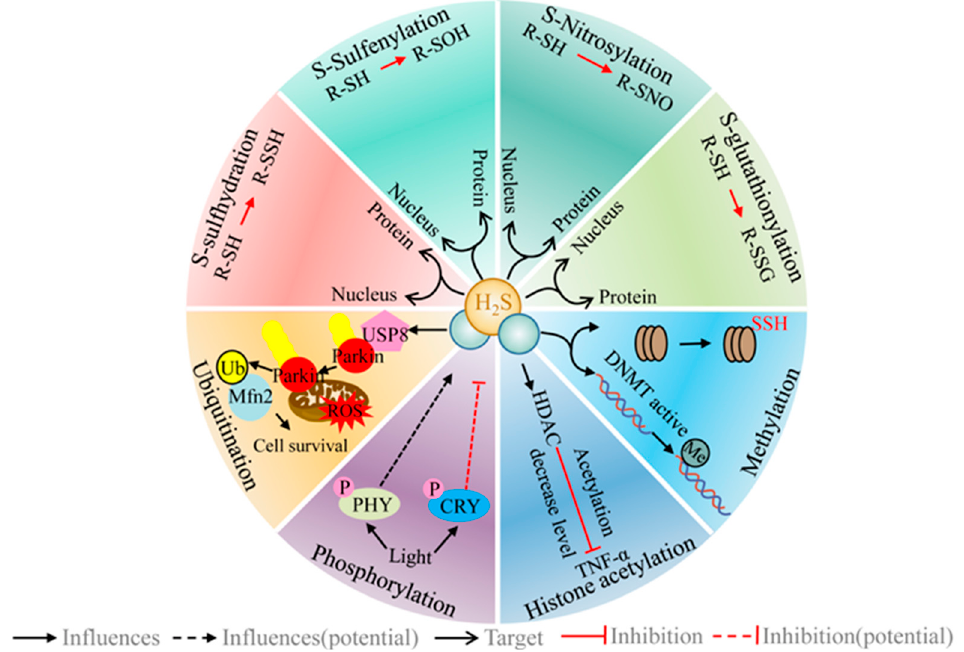
Figure 6. H 2 S regulates a range of different PTMs/signaling systems. CRY (cryptochromes), DNMTs (DNA methylation transferases), HDACs (histone deacetylases), Mfn2 (mitofusin-2), PHY (phytochromes), TNF- α (tumor necrosis factor- α ), Ub (ubiquitin), USP8 (ubiquitin-specific peptidase 8).